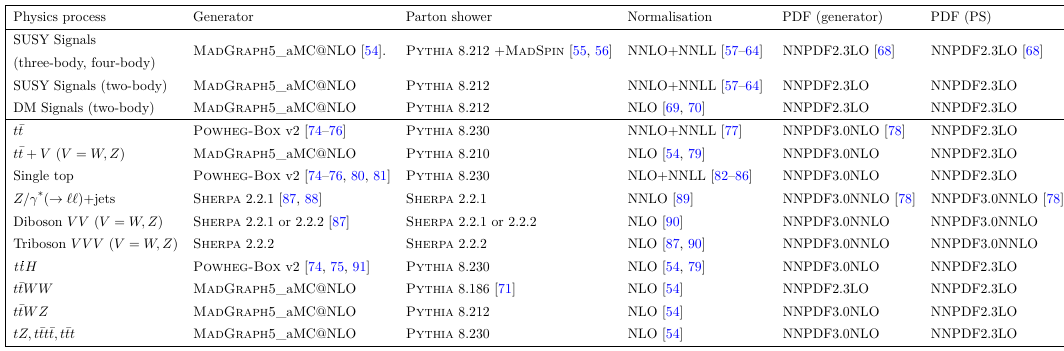
Table 1 . Simulated signal and background event samples with the corresponding matrix element and parton shower (PS) generators, cross-section order in α the generator and PS PDF sets